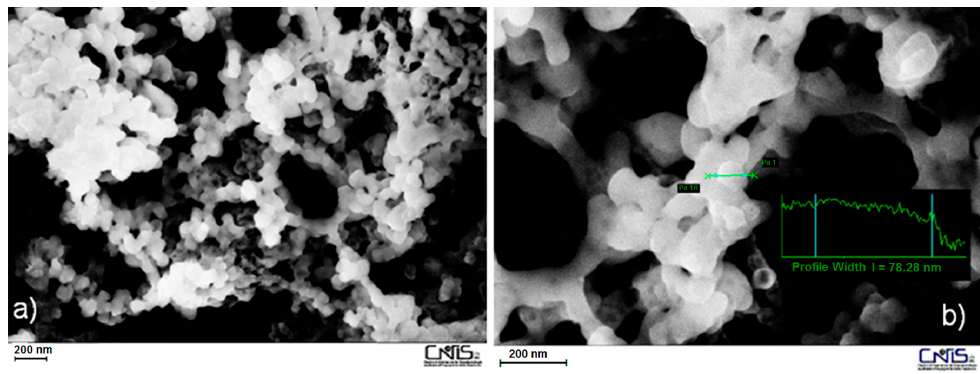
Figure 5. ( a ) A SEM image of S–TiO 2 core–shell particles;( b ) a detail of the same image reporting the size of a particle.